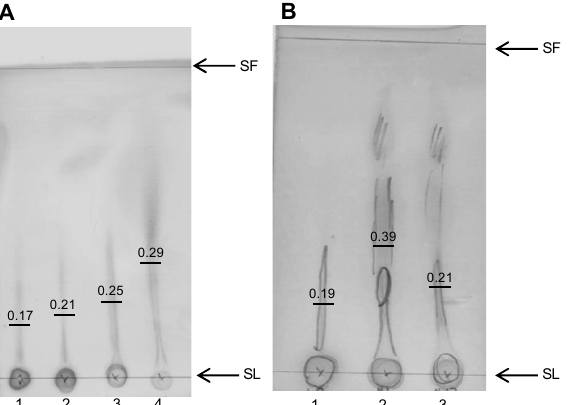
Figure 6. Thin layer chromatography (TLC) plates spotted with ( A ) 1: Native MLD, 2: 5 min heat degraded MLD, 3: 15 min heat degraded MLD, 4: 60 min heat degraded MLD and ( B ) 1: Native MLD, 2: Day 16 MLD colonic vessel and 3: Day 16 control colonic vessel. Solvent Fronts (SF) and Spotting Lines (SL) are indicated. Retention values are calculated and represented on the TLC with a midline.